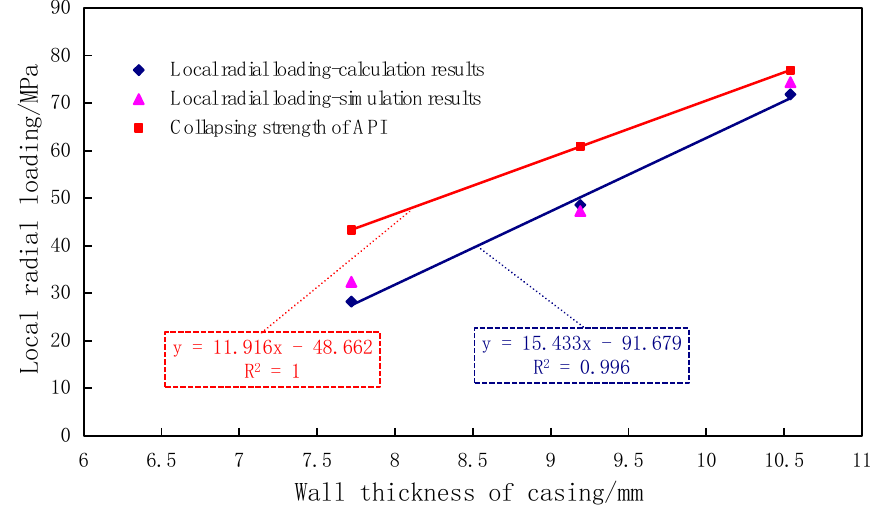
Figure 10. Calculation results of deformation on different wall thicknesses of 5½ ″ N 80 -type casing.